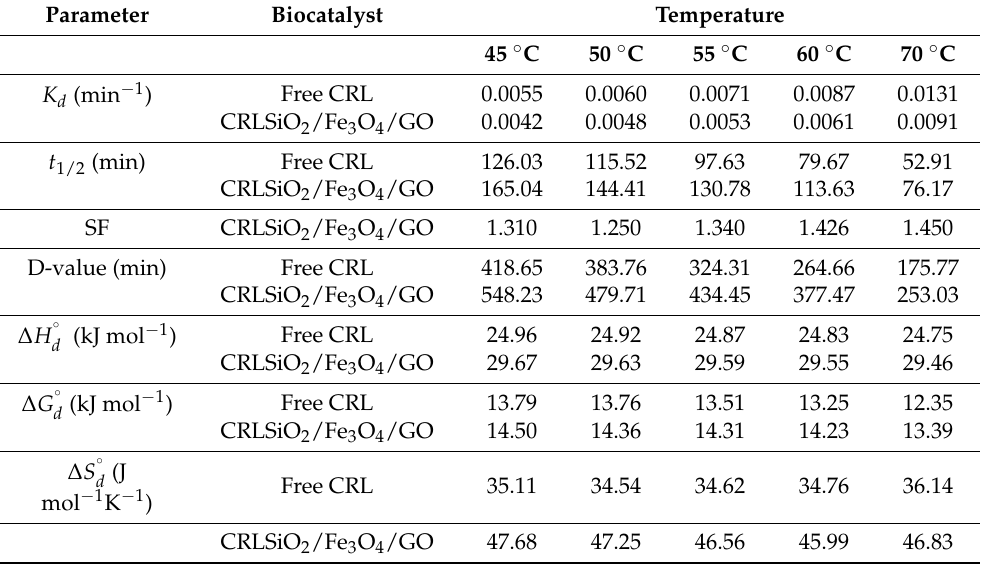
Table 2. Thermodynamic and thermal denaturation parameters for free CRL and CRLSiO 2 /Fe 3 O 4 /GO.